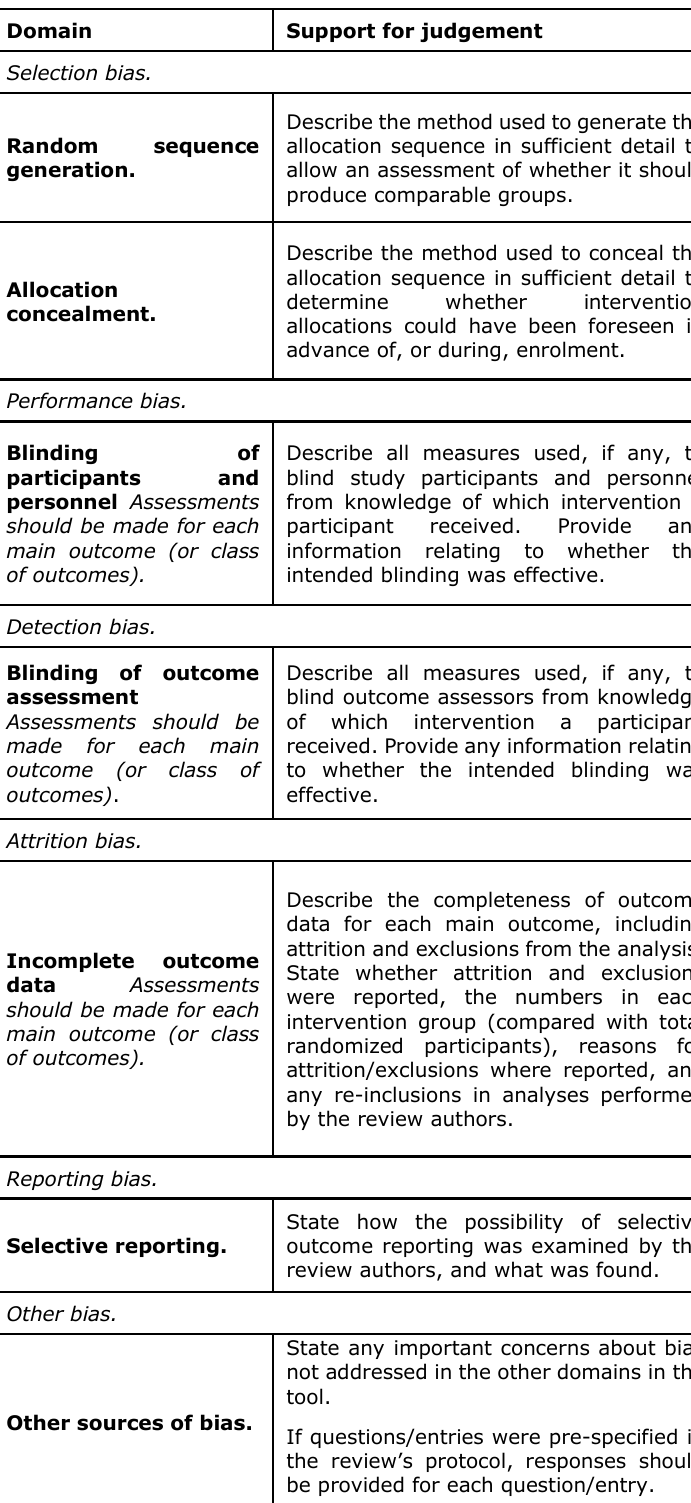
Table 2 – The Cochrane Collaboration’s tool for assessing risk of